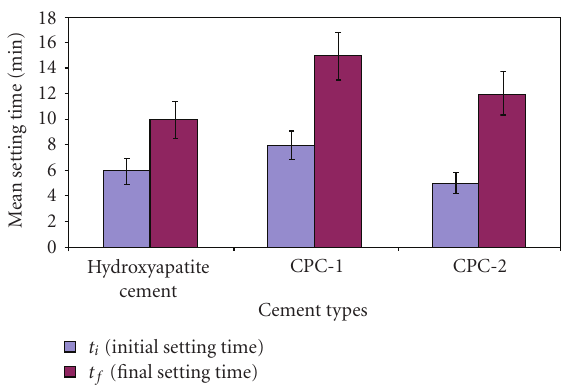
Figure 1: Histogram showing the mean initial and final setting times (inmin) of hydroxyapatite cement and the two polymeric calcium phosphate cements (CPCs).